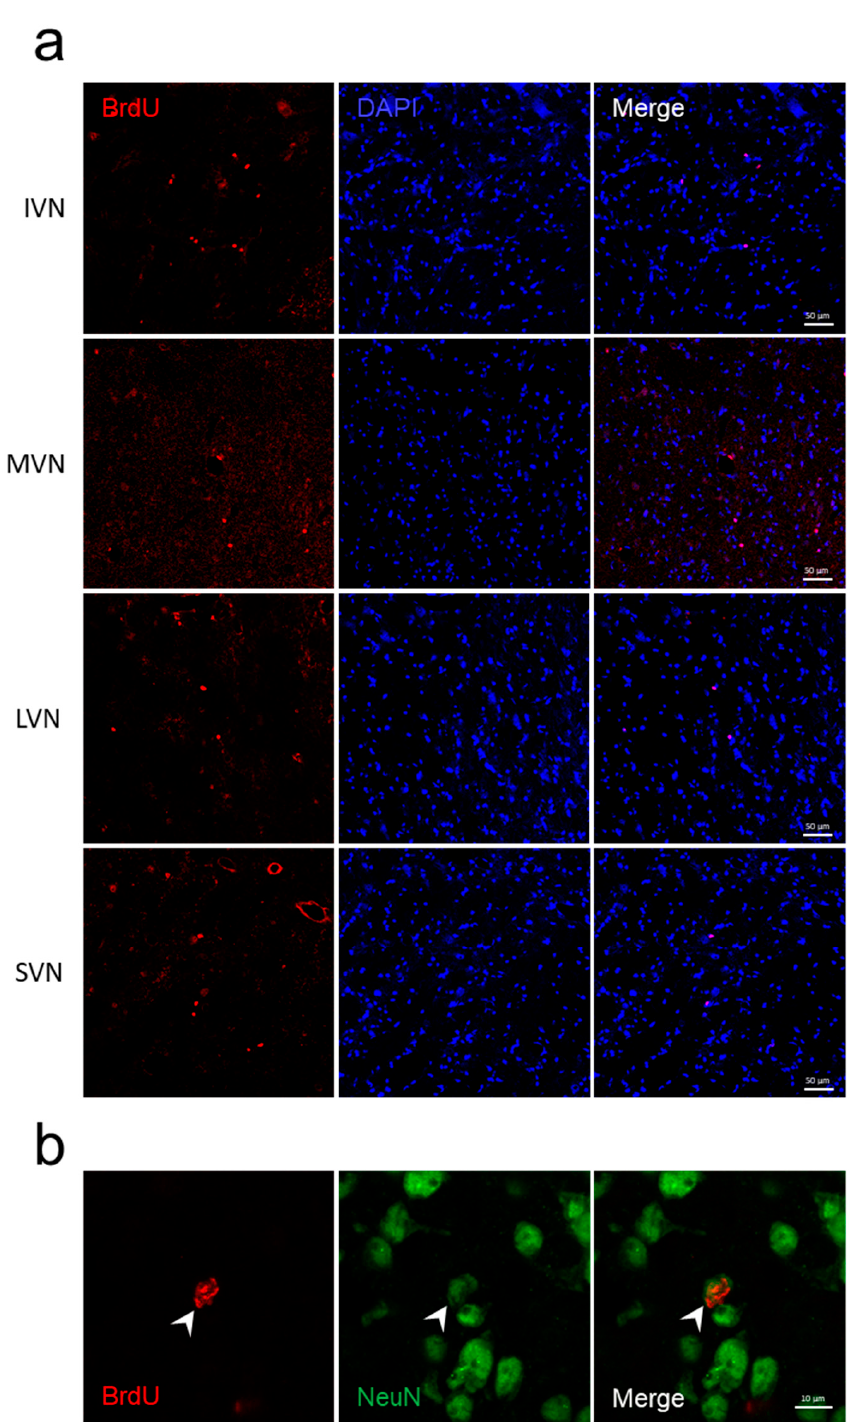
Figure 2. Cell proliferation and differentiation in neurons in the vestibular nuclei of adult control rats . ( a ) Representative images of proliferative cells (BrdU+) in all vestibular nuclei of adult control rats. IVN = inferior vestibular nucleus; MVN = medial vestibular nucleus; LVN = lateral vestibular nucleus; SVN = superior vestibular nucleus. Scale bar, 50 µ M. ( b ) Maximum intensity orthogonal projection of the confocal Z-stack of newly generated neurons in the MVN of adult control rats. Arrowheads indicate the colocalization of BrdU+ (in red) and NeuN+ (neuronal marker in green). Scale bar, 10 µ